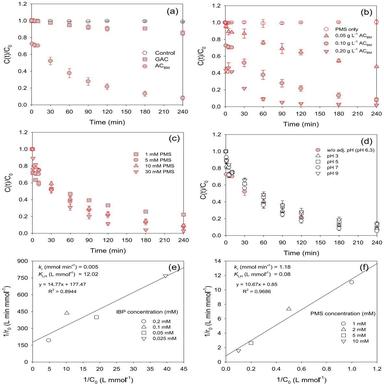
(a) Selection of catalyst materials for effective degradation of IBP with PMS system; Optimization of key parameters for IBP degradation; (b–e) effect of (b) catalyst dosage; (c) oxidant concentrations; (d) initial solution pH; Langmuir-Hinshelwood (L–H) kinetic model for heterogeneous catalytic properties of ACBM with different initial concentrations of (e) IBP and (f) PMS system. Experimental conditions: = 0.1 mmol L− 1 , = 5 mmol L− 1 , = 0.1 g L− 1 , pH = 6.3 and T = 25 ◦C.